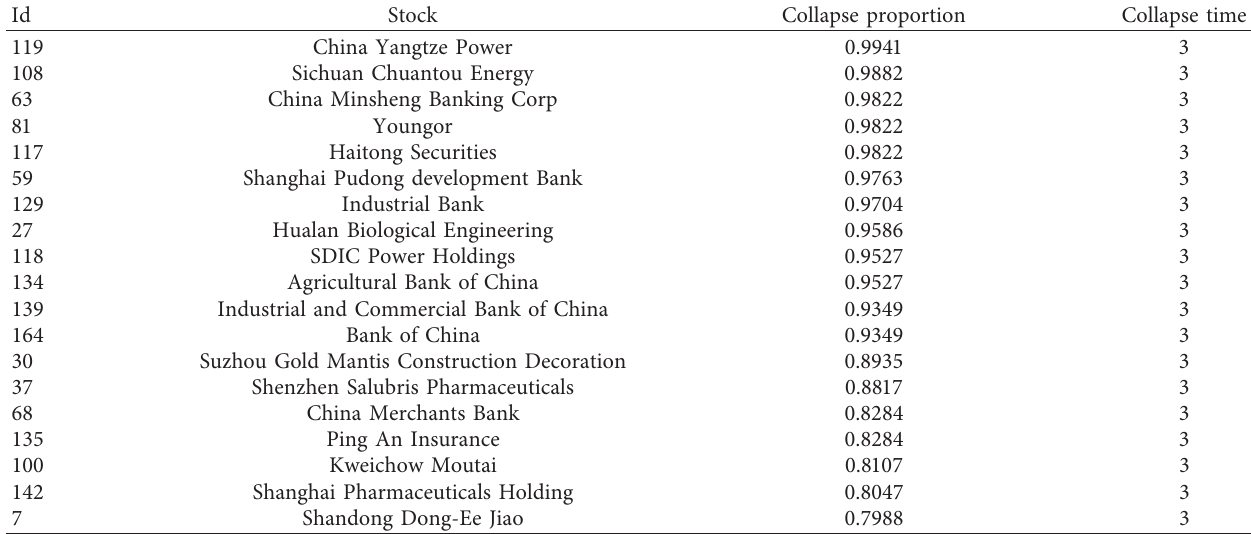
Table 9: Top 20 stocks with disturbance power in collapse